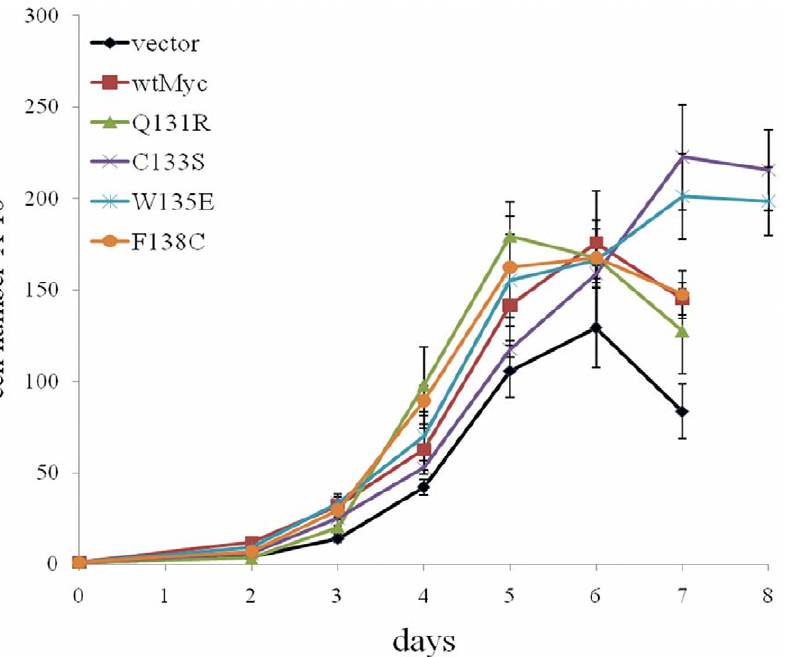
Figure 2. Effect of Myc point mutations on proliferation. The indicated Rat1a cell lines were seeded at 10 4 cells/well in 12 well plates and allowed to attach in medium containing 10% FBS. At the indicated times, the total cell number in triplicate wells was determined. The points shown represent the average number of cells/well + / 2 1 standard error (SE). The experiment was repeated on at least three occasions with similar results. Only adherent cells were counted. The number of cells at the latter time points may be affected by contact inhibition or cell loss due to overgrowth.